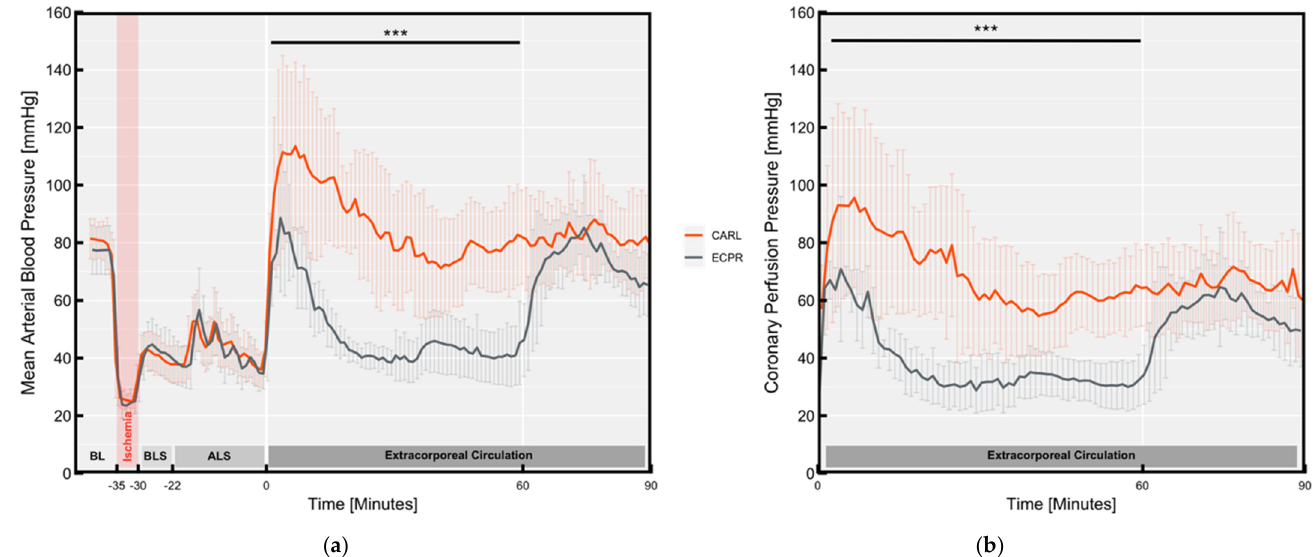
Figure 3. Longitudinal course of haemodynamic parameters: ( a ) Mean arterial blood pressure; ( b ) Coronary perfusion pressure. Data are expressed as mean ± SD. BL Baseline, BLS Basic life support, ALS Advanced life support. (*** p < 0.001).